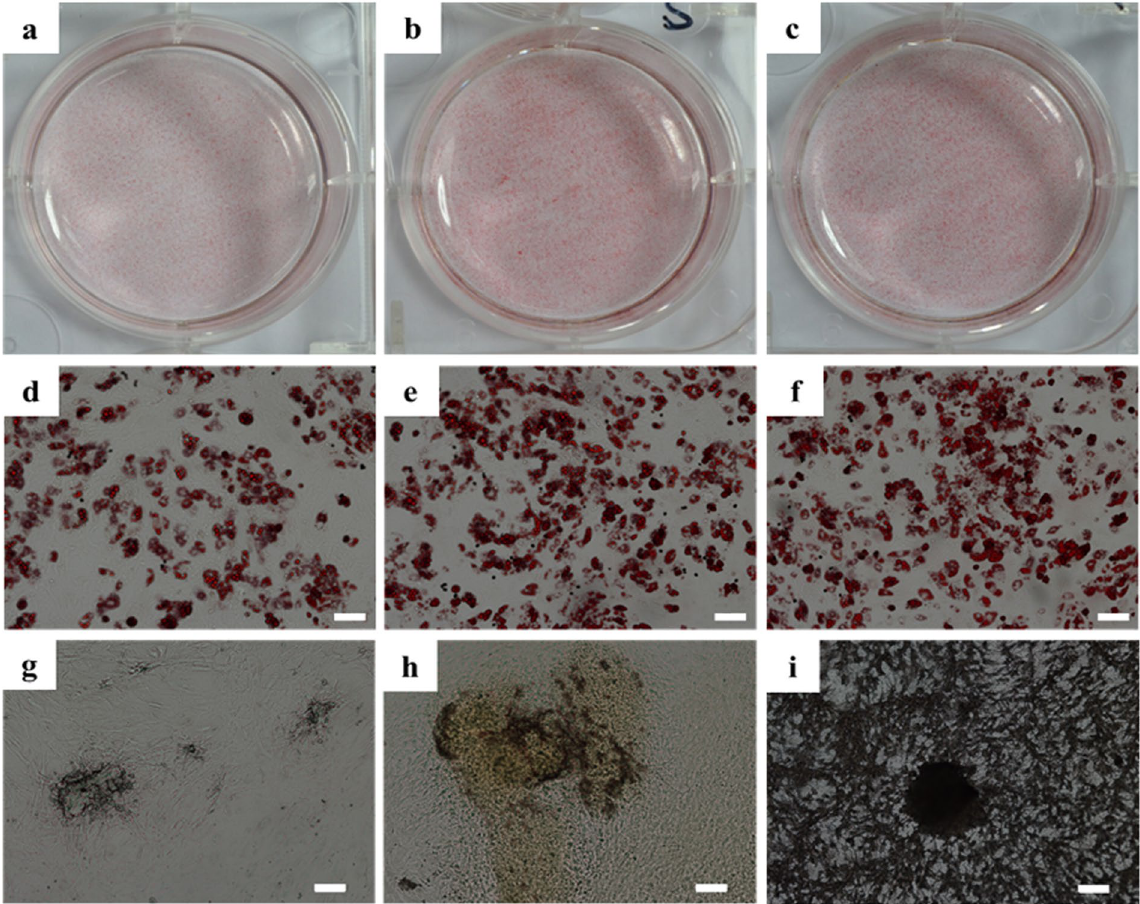
Figure 11. Oil red O staining ( a–f ) and Von kossa staining ( g–i ) of BMSCs transplanted to 2D plates for 21 days adipogenic and osteogenic